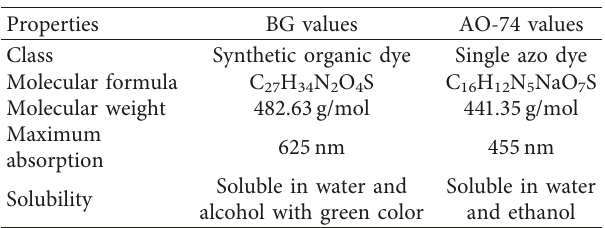
Figure 1: Structure of dyes. (a) Brilliant green. (b) Acid orange 74. Table 1: Properties of BG and AO-74